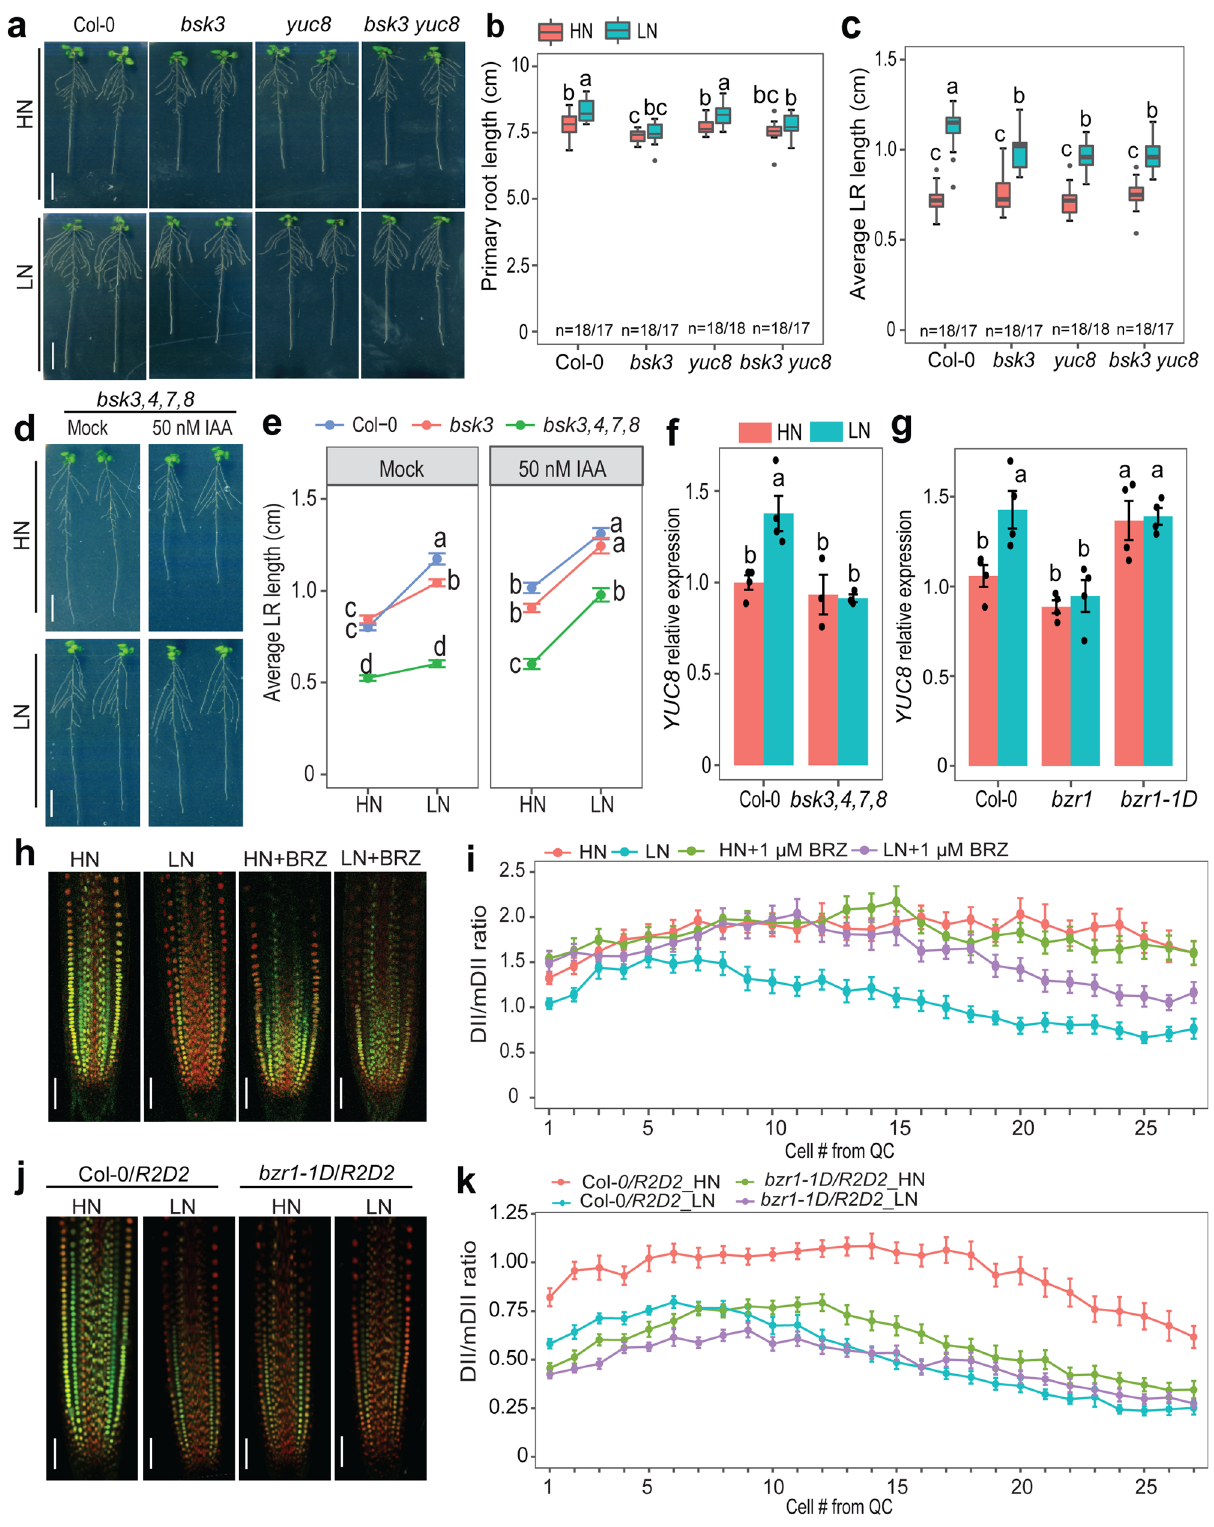
exogenous BR supplies. In contrast, the LR foraging response to LN of the BR signaling mutants bsk3 and bsk3,4,7,8 as well as of the BR biosynthesis mutant dwf4-44 was restored under exo- genous application of IAA (Fig. 5d, e and Supplementary Fig. 22). These results reveal a dependency of local auxin biosynthesis in LRs on BR function and place local auxin biosynthesis down- stream of BR